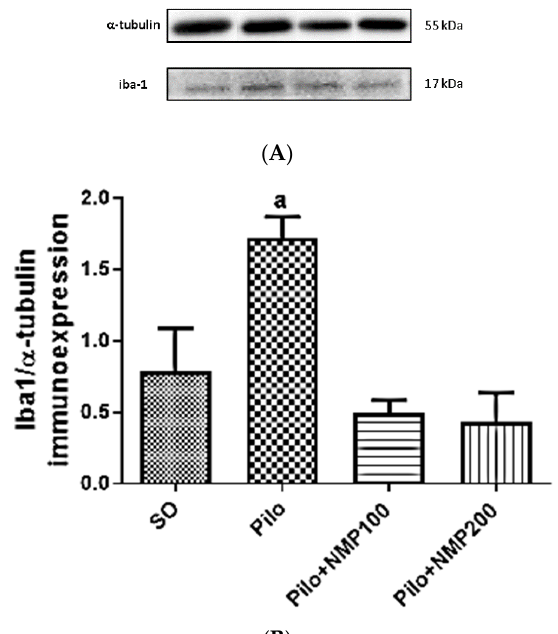
Figure 4. The N - methyl-(2S,4R)-trans-4-hydroxy- L -proline-rich fraction (NMP) partly reversed the increased microglia activation, in mice subjected to the intracerebroventricular (icv) injection of pilocarpine (Pilo), compared with the SO group as evaluated by western blot for the ionized calcium-binding adaptor molecule 1 (Iba-1). Representative blots ( A ) show the higher intensity band which corresponds to standard α -tubulin (55 kDa), and the 15 kDa band which corresponds to the Iba-1 band (four mice per group). Below, the densitometric quantification of the bands ( B ), performed by the Image J software (NHI, USA), is shown. a. vs. SO, p < 0.0033 (one-way analysis of variance and Dunnett’s multiple comparisons test).